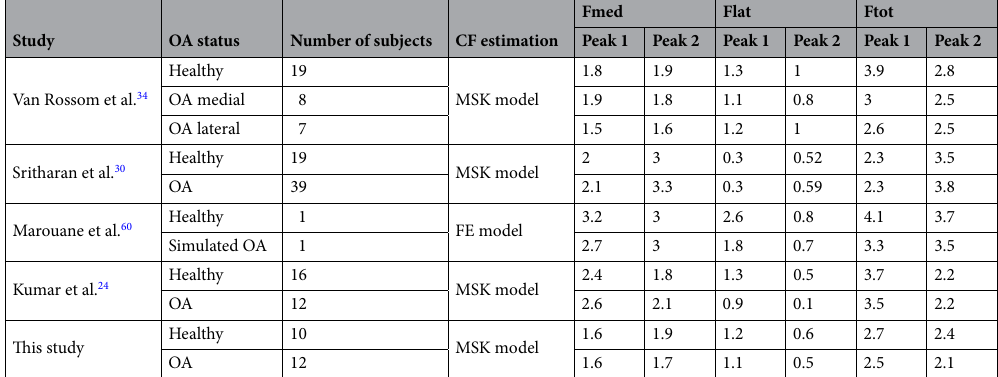
Table 3. The 1st and 2nd peaks of medial contact force (pk1–pk2 Med), 1st and 2nd peaks of the lateral contact force (pk1–pk2 Lat), and 1st and 2nd peaks of the total contact force (pk1–pk2 Tot) in the case- control studies with OA and healthy subjects. The contact force (CF) estimations (BW) were obtained using musculoskeletal (MSK) or finite element (FE)